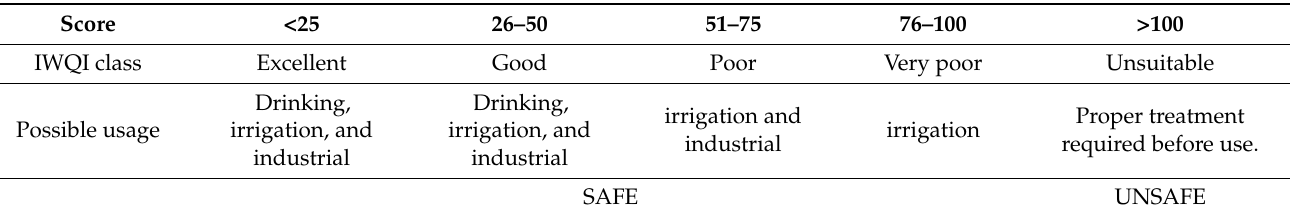
Table 2. Classification of water quality according IWQI score.